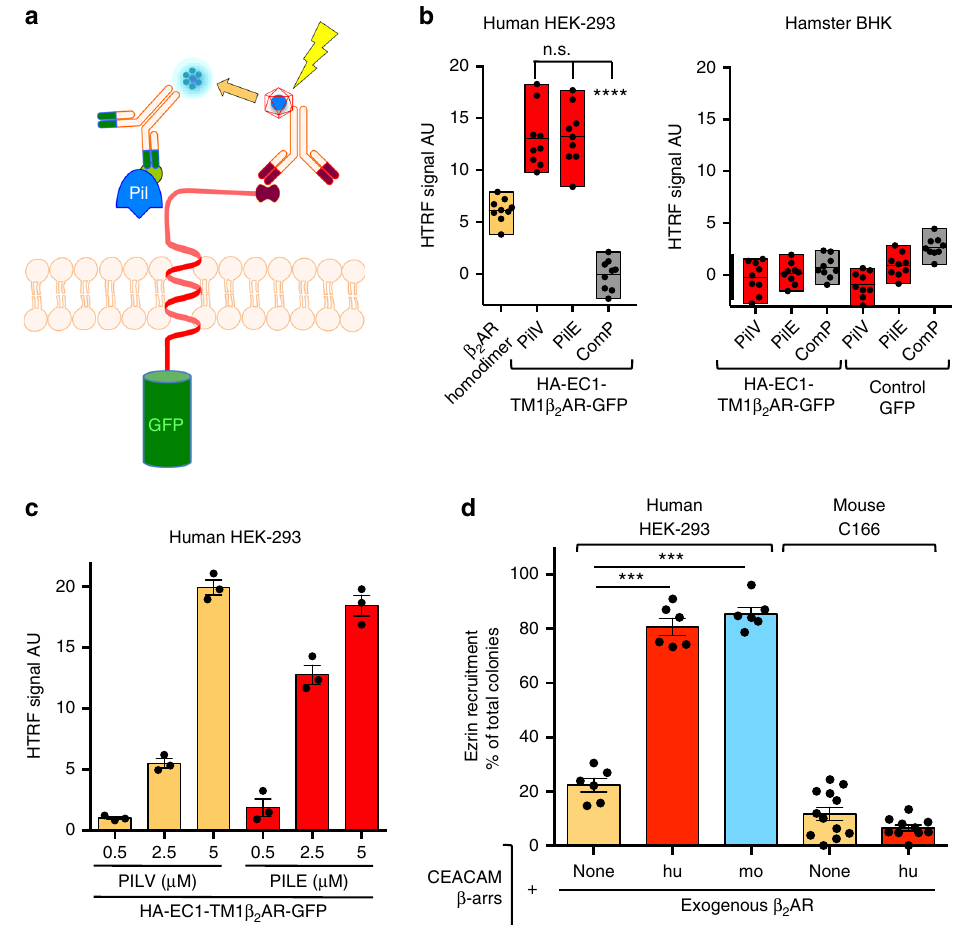
Fig. 1 β 2 AR activation involves the direct interaction of pilins with receptor N-terminus. a Diagram of the HTRF assay. Cells expressing comparable amounts (GFP signal) of the HA-EC1-TM1 β 2 AR-GFP construct were incubated with excess recombinant pilins (Pil) containing a 6×His N-terminal tag. Anti-HA-Tag antibodies coupled to the cryptate donor and anti 6×His-Tag antibodies coupled to the acceptor fl uorophore were then added for 1 h before excitation at 320 nm and reading (FRET emission at 665 nm) in a Mithras2 Lysogeny Broth (LB) 943 HTRF reader. b HTRF signal obtained with PilV, PilE, and ComP